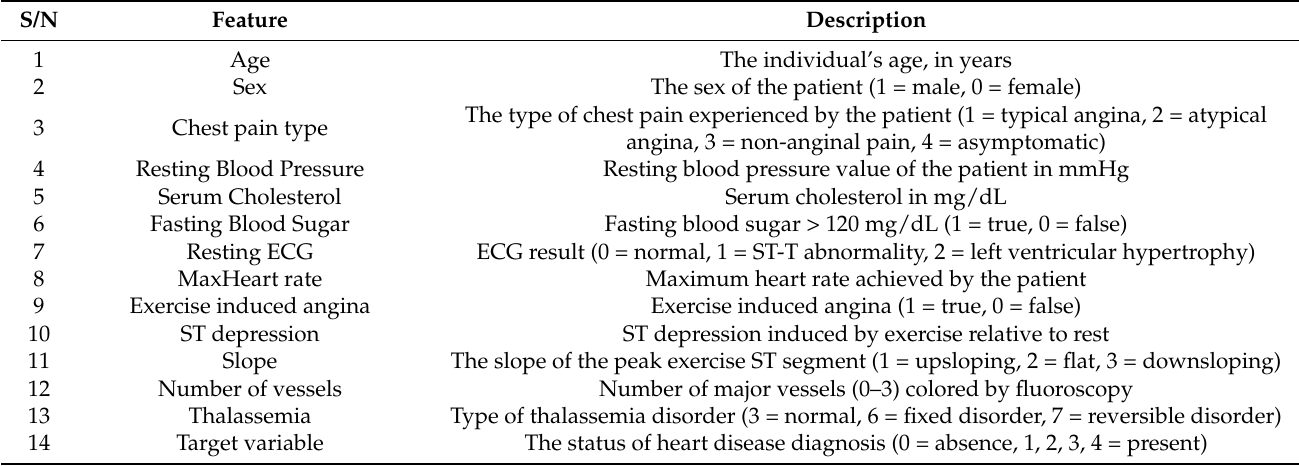
Table 1. Features in the Cleveland datasets.